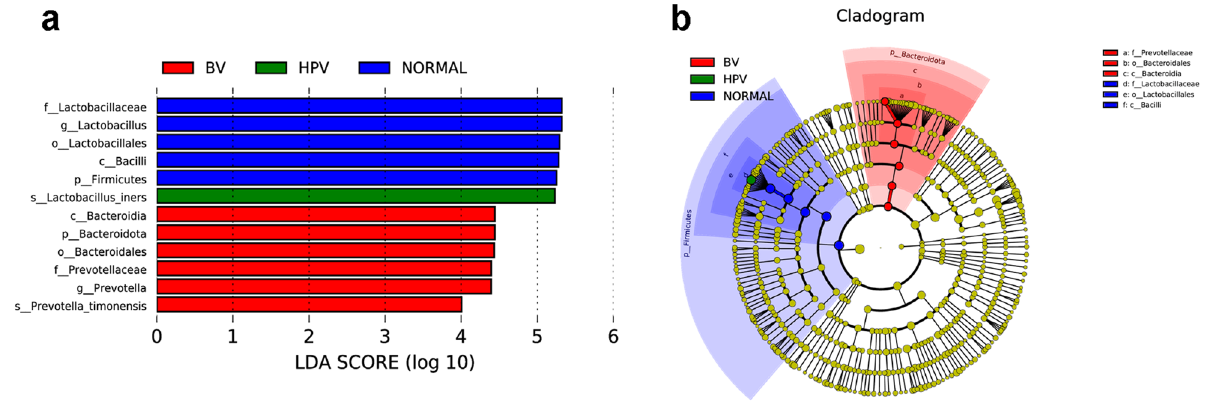
Figure 5. Metagenomic biomarker between 6 groups using LEfSe analysis. ( a ). Enrichment in bacterial taxa between 6 groups. The threshold for the LDA score was 4.0. Groups with no statistically significant species were not shown in the figure. ( b ). Cladogram for different bacteria between groups. Non-significant biomarkers are shown in yellow, and significantly different biomarkers are dyed the same color as the corresponding group. Alpha value for the Kruskal–Wallis rank sum test was